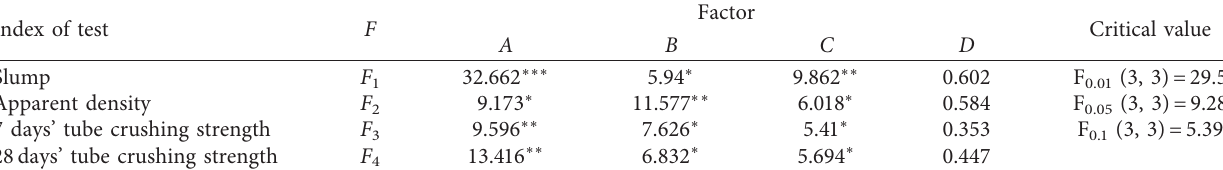
Table 11: F test results.